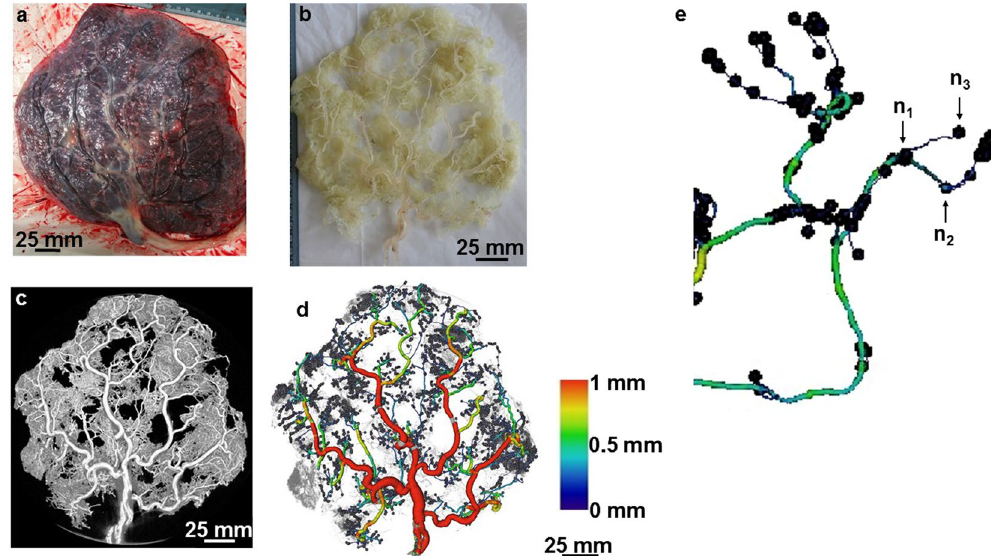
Figure 1. An example of a scanned and analysed arterial cast of a normal placenta. The images show an arterial cast ( b ) following corrosion casting of a normal placenta ( a ), a 3D reconstructed image of the arterial cast following micro-CT scanning ( c ) and analysis in Avizo ( d ). Vessels are coloured based on their diameter. The image in panel e is a section of an analysed cast zoomed to show nodes placed at a true vessel branch point (n 1